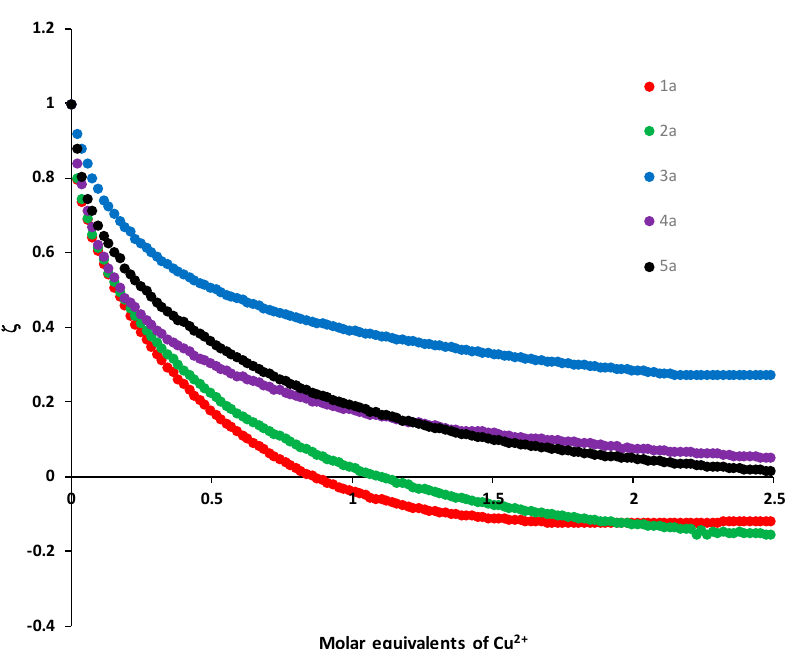
Figure 7. Normalized zeta potential profiles obtained by the titration of the derivative with Cu 2 +